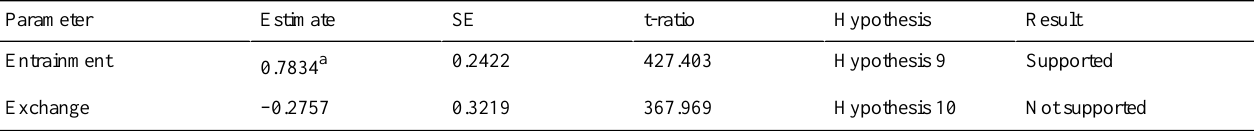
Table 3. Exponential random graph model estimates of cross-network effects for the two social support networks. ResultHypothesist-ratioSEEstimateParameter